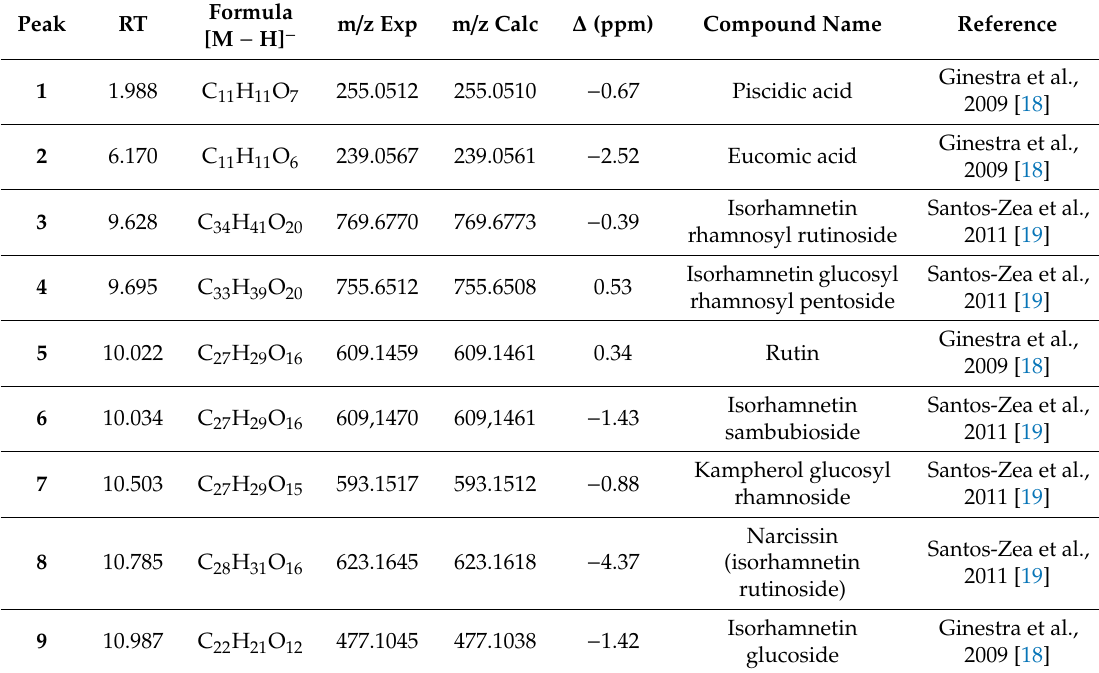
Table 1. Identification of phenolic acids and flavonols in Opuntia ficus-indica extracts (from imm and m ) by means of High performance liquid chromatography time-of-flight mass spectrometry HPLC / TOF (M − H) − .